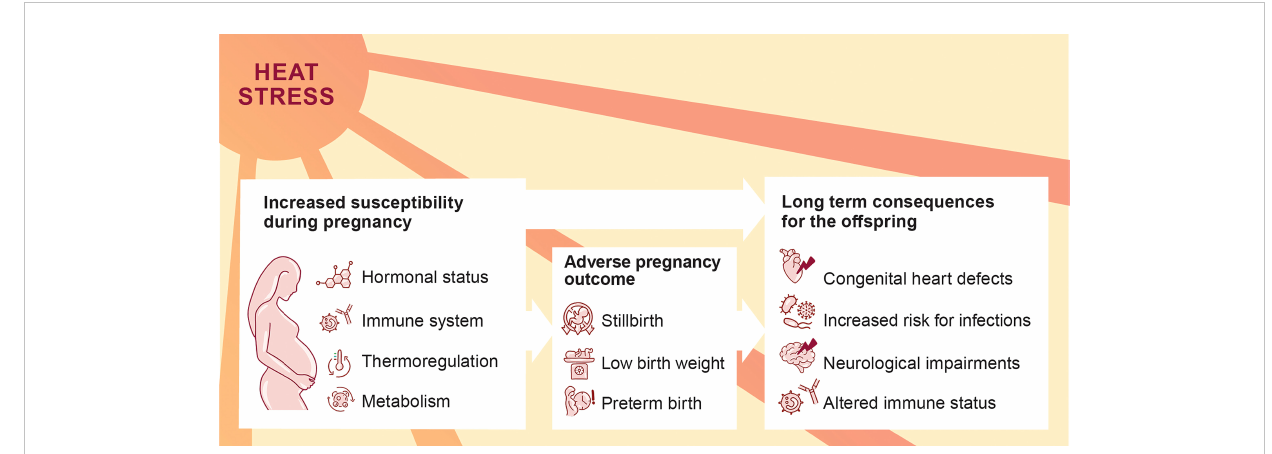
FIGURE 1 Increased susceptibility of pregnant women to heat stress with possible consequences for the progression of pregnancy and offspring ’ s